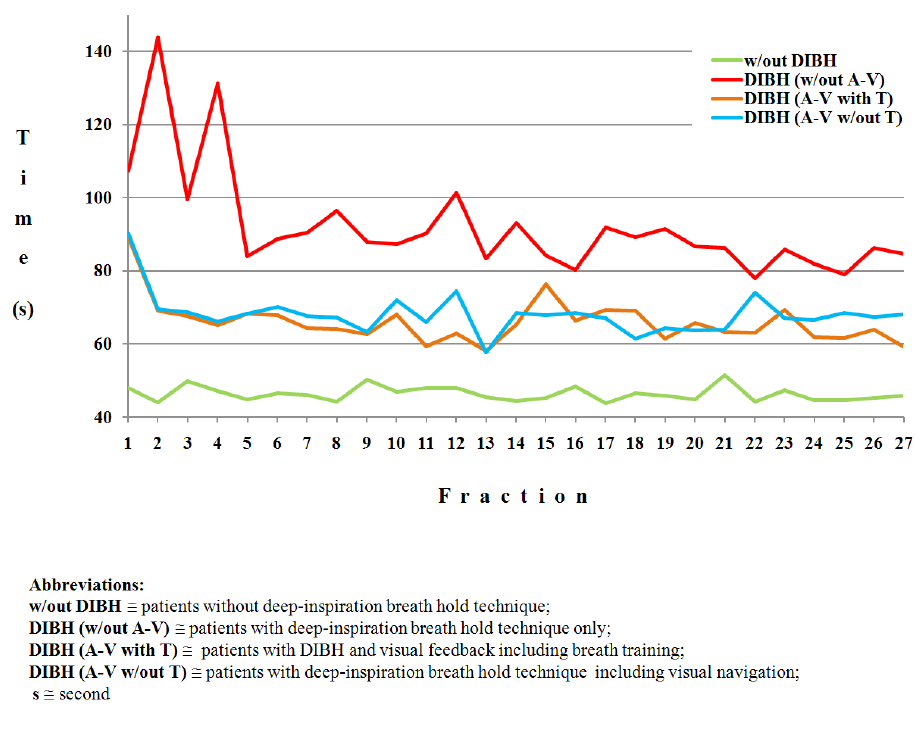
Fig. 1. Treatment times for each fraction converted per field.